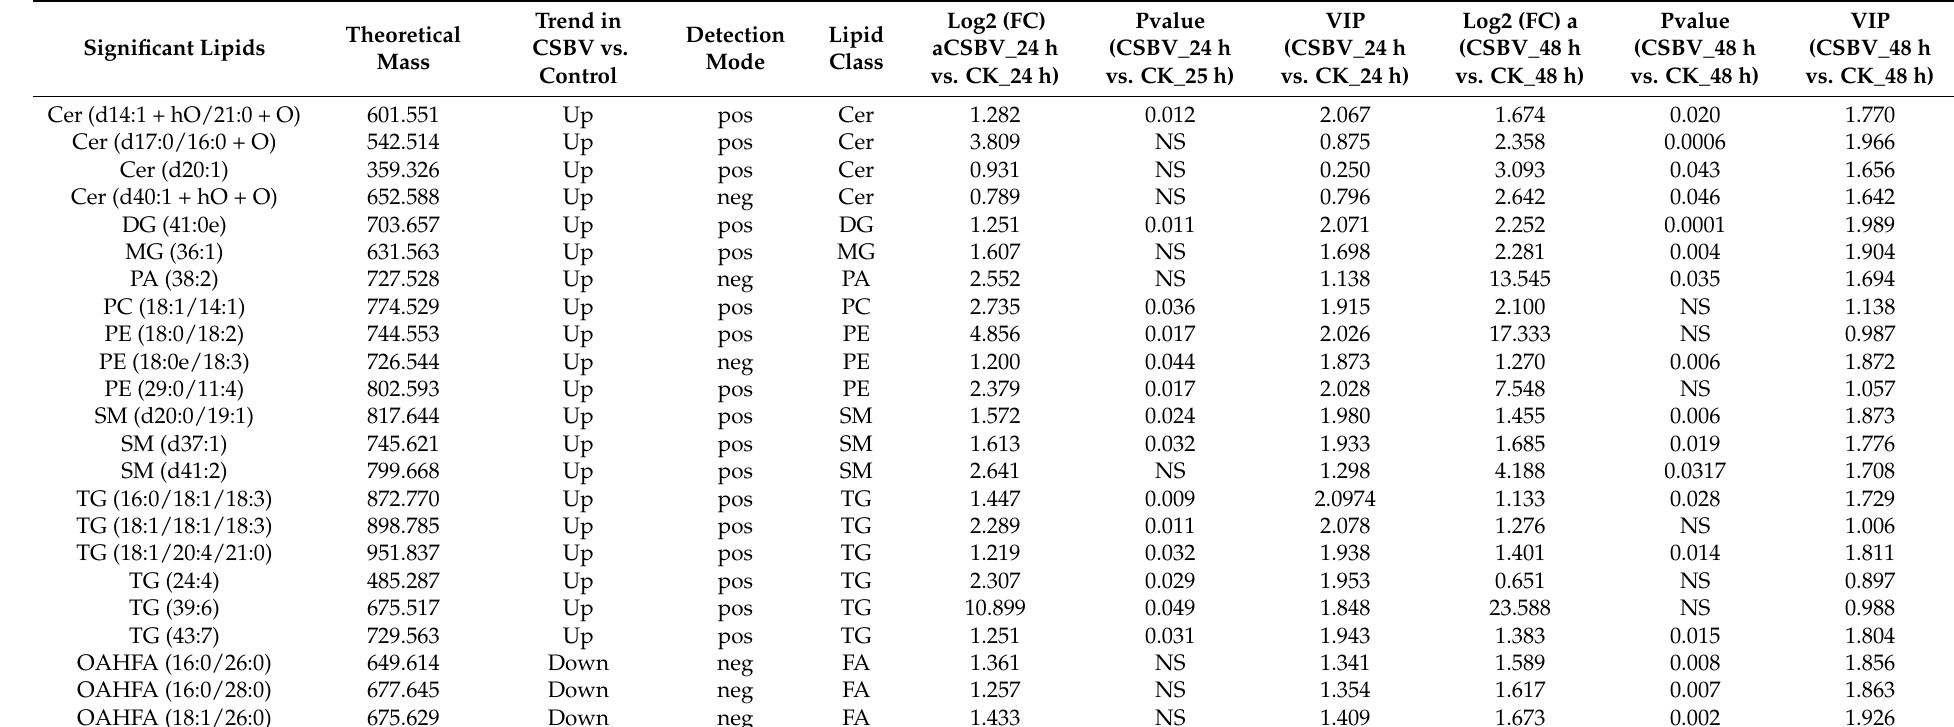
Table 2. Lipid markers detected by Principal Component Analysis from the CSBV-infected